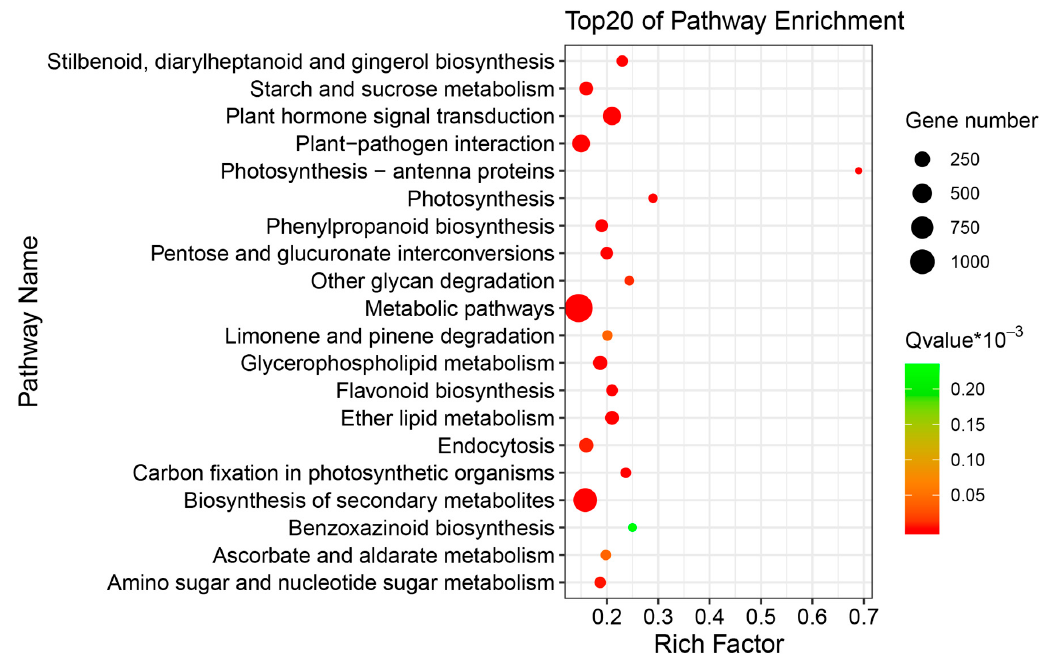
Figure 3. The differentially expressed genes (DEGs) with Kyoto Encyclopedia of Genes and Genomes (KEGG) pathway enrichment (top 20) in tartary buckwheat in response to salt stress.